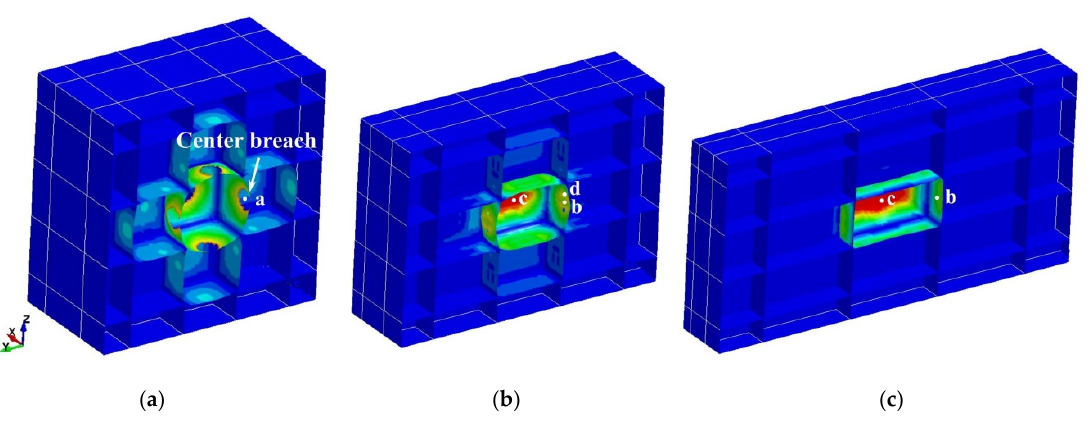
Figure 5. Damage of multi-box structures of different structural dimensions (Unit: cm): ( a ) 120 × 120 × 120; ( b ) 84.8 × 169.7 × 120; ( c ) 60 × 240 × 120.